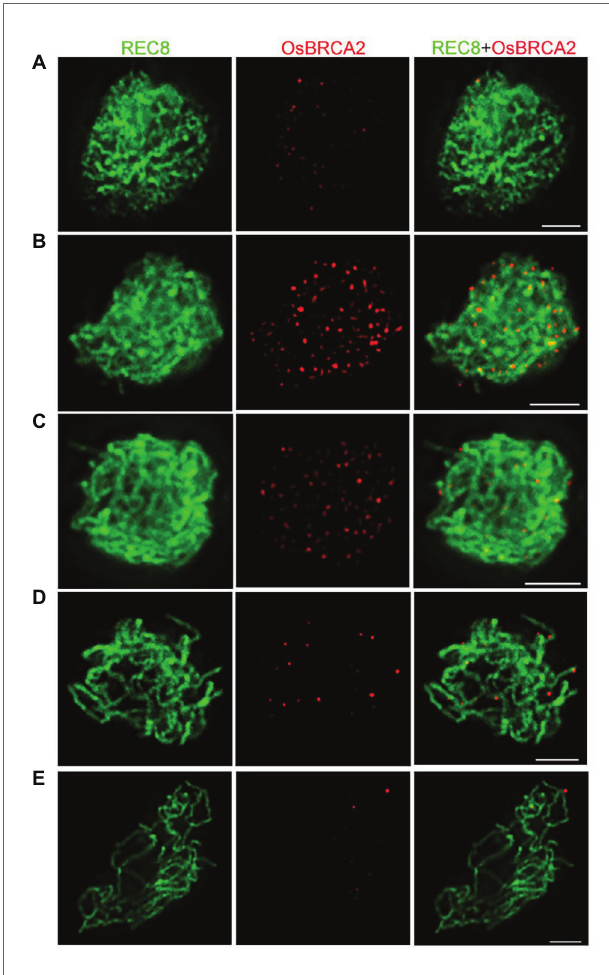
FIGURE 3 | Dual immunolocalization assay of OsBRCA2 (red) and REC8 (green) in the wild-type meiocyte cells. (A) Late leptotene. (B) Zygotene. (C) Late zygotene. (D) Early pachytene. (E) Late pachytene. Bars = 5 μ m. FIGURE 4 | Meiotic chromosome behavior of male meiocytes in the wild-